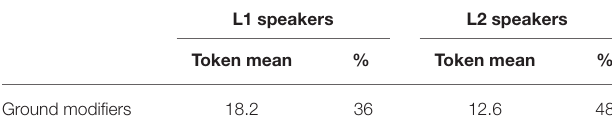
TABLE 5 | Ground modifiers in L1 and L2